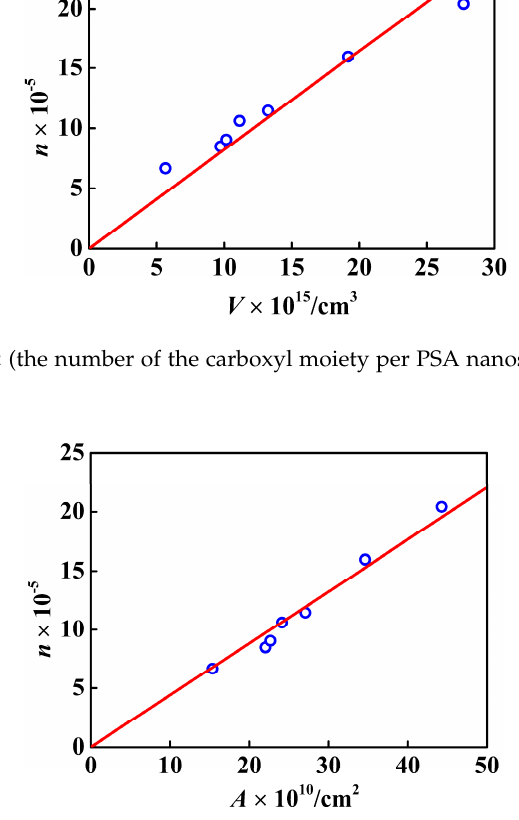
Figure 9. Variation of n (the number of the carboxyl moiety per PSA nanosphere) with A (the PSA nanosphere surface area).